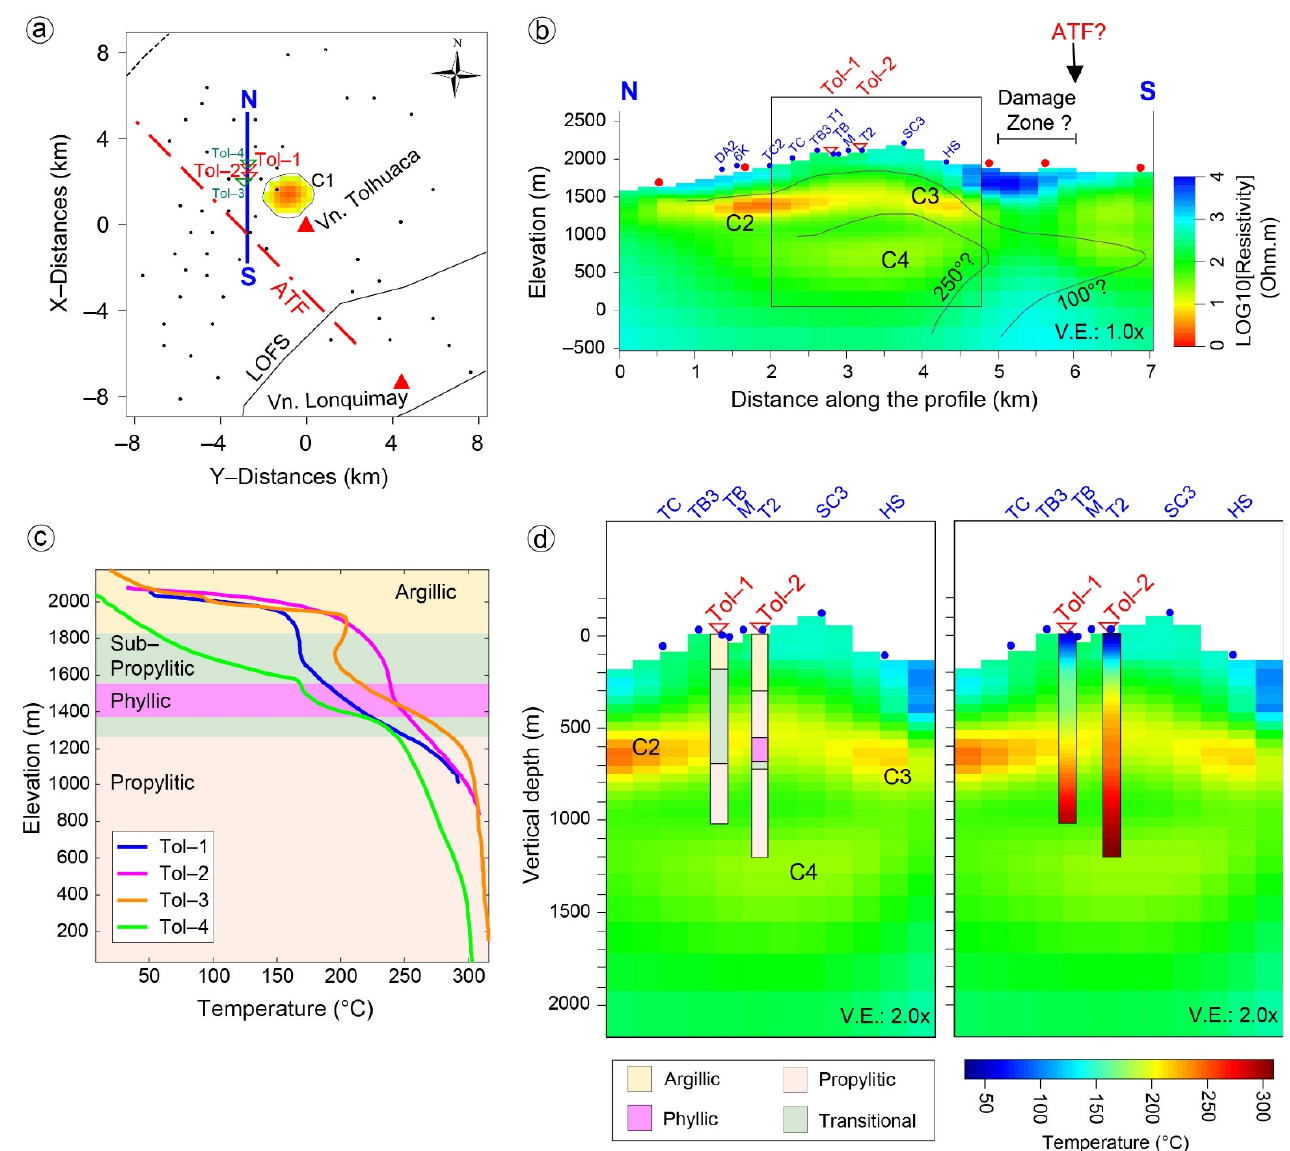
Figure 9. ( a ) Location of the N-S profile shown in b. ATF: Andean Transverse Fault; LOFS: Liquiñe- Ofqui Fault System; Tol-1, Tol-2: slim wells; Tol-3, Tol-4: deep wells. Black dots represent MT stations. ( b ) N-S vertical section with a vertical exaggeration of 1x. Section running parallel to wells and the thermal manifestation and located to the west of the high conductive anomaly. The figure also includes an interpretation of the well temperature (modified after [21]). Blue dots represent hot springs. ( c ) Temperature vs. elevation profiles for the Tol-1 (blue line), Tol-2 (magenta line), Tol-3 (orange line), and Tol-4 (green line) wells (modified after [17]). Four structural-mineralogical zones are shown as a reference (modified after [14,17]). ( d ) Zoom of the central part of the N-S section shown in b. The figure includes hydrothermal alteration units from Tol-1 and Tol-2 wells [14], the ~300 m thick uppermost high conductive anomaly, and the lower low-intermediate conductive anomalies. Note that the scale refers to the vertical extension of the wells.